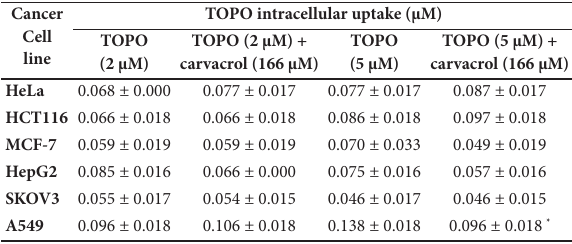
Figure 2. The effect of the 24 h treatment with (TOPO (2 or 5 µM) + carvacrol (166 µM)) combination on TOPO cellular uptake in (A) HeLa, (B) HCT116, (C) MCF-7, (D) HepG2, (E) SKOV3 and (F) A549 cell lines. Data were expressed as mean ± SD (error bars), n = 3. The significant differences between the different (TOPO + carvacrol (166 µM)) combinations at each time assessed by mesuring the P -values using the independent t -test, were classified to * P < Table 2. Effect of carvacrol/TOPO combination therapy on TOPO cellular uptake in different cancer cell lines. Data were expressed as mean ± SD, in triplicate.